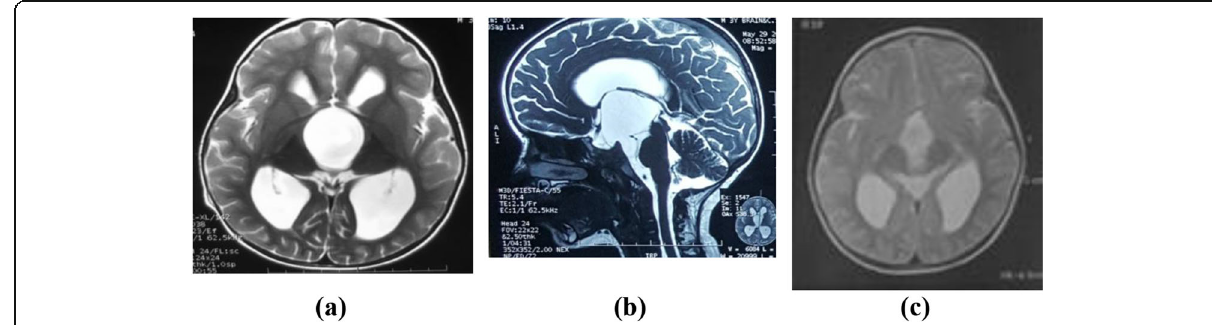
Fig. 6 a MRI T2 axial sequence showing suprasellar arachnoid cyst bulging inside the third ventricle in a 3-year-old male. b MRI T2 sagittal sequence